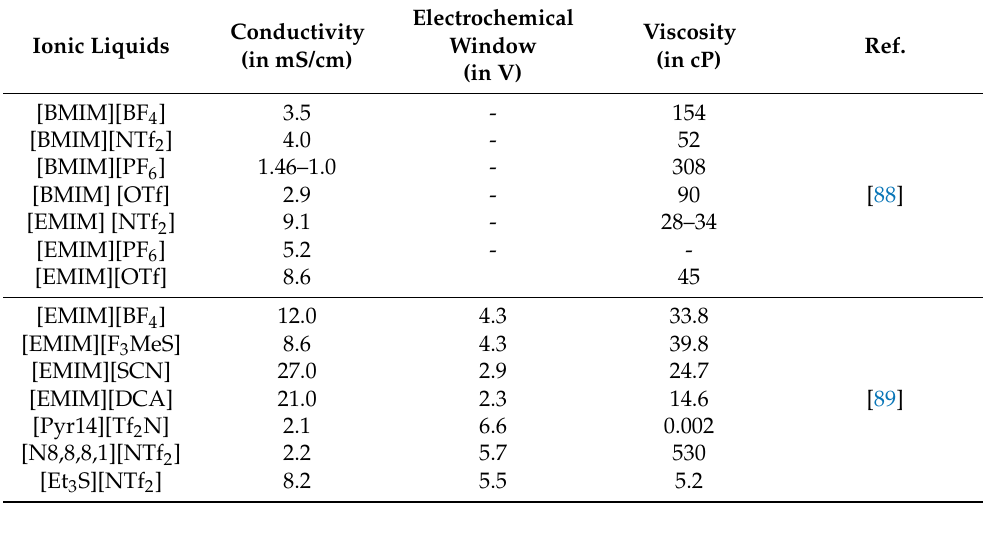
Table 1. Conductivity and electrochemical stability of ILs. (mS/cm- milliSiemens/centimeter; V-volt; cP- centipoise).